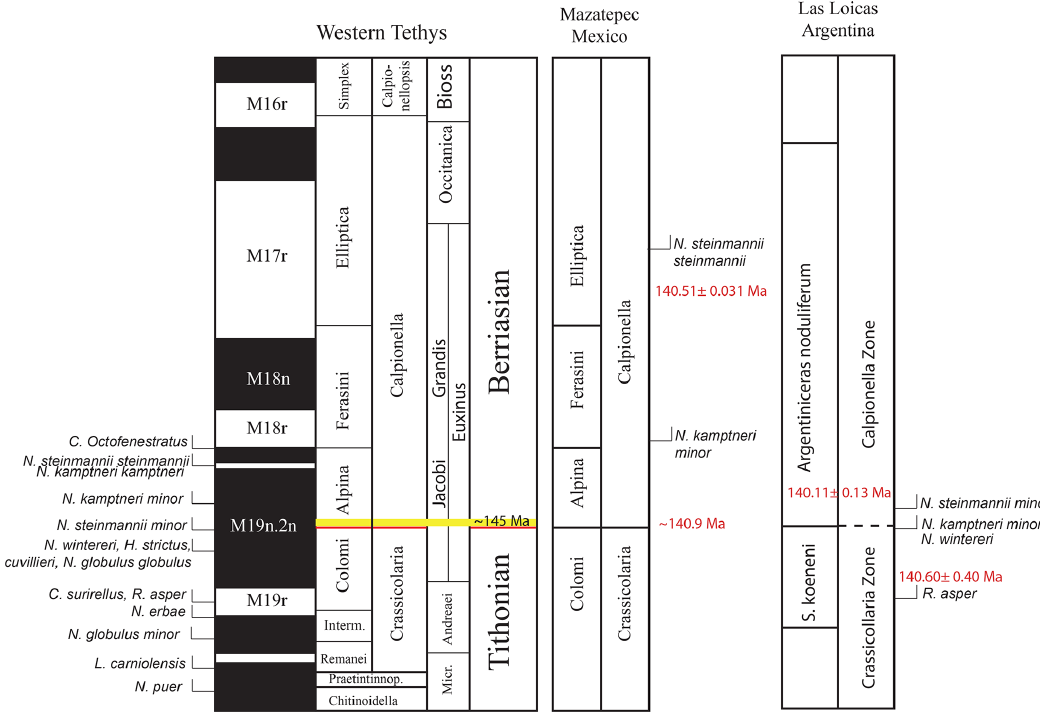
it is used as an upper limit to the base of the Alpina Sub- zone (Wimbledon et al., 2013). In Mazatepec, the FO of